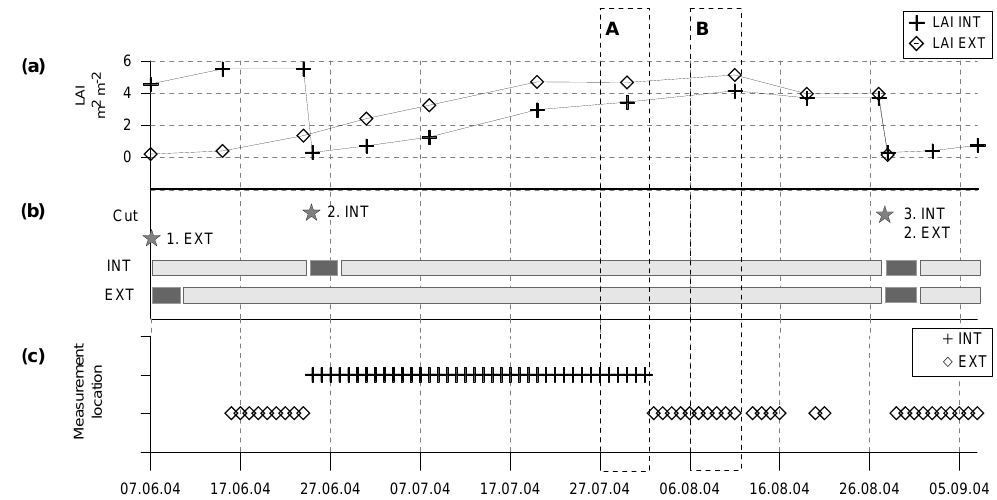
Fig. 2. Field experiment summer 2004, overview on the growing state of the fields, the event-related methanol emission, and the measure- ments between 7 June and 7 Sep: (a) LAI of the intensive and the extensive site, (b) cuts of the intensive (25.06 and 28.08.04) and the extensive (07.06 and 28.08.04) site, classification into cut-related (dark-grey bar) and growth-related (light-grey bar) emission periods,